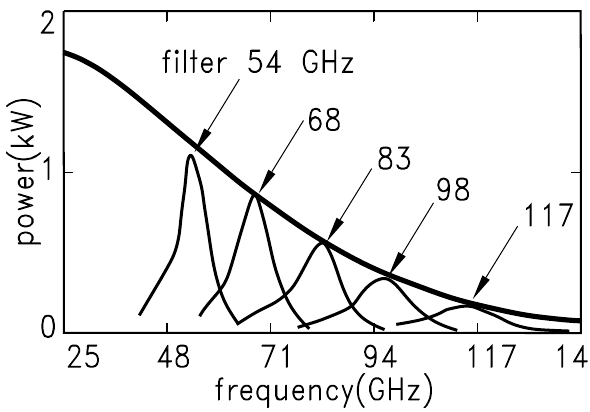
pC.FIG. 5. Example of the detector response (after the 68 GHz filter, and the bunch with (cid:14) z (cid:1) 5 : 6 psec ); the horizontal scale is 1 ns = div ; the vertical scale is 20 mV = div .